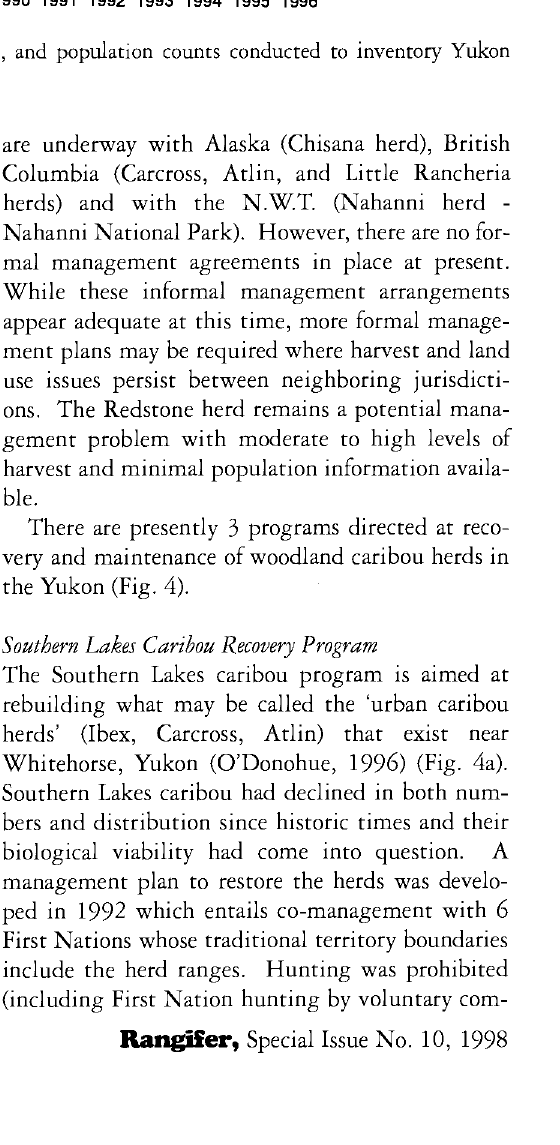
Fig. 2. Number of caribou radio-collared, relocation flights, and population counts conducted to inventory Yukon woodland caribou between 1980 and